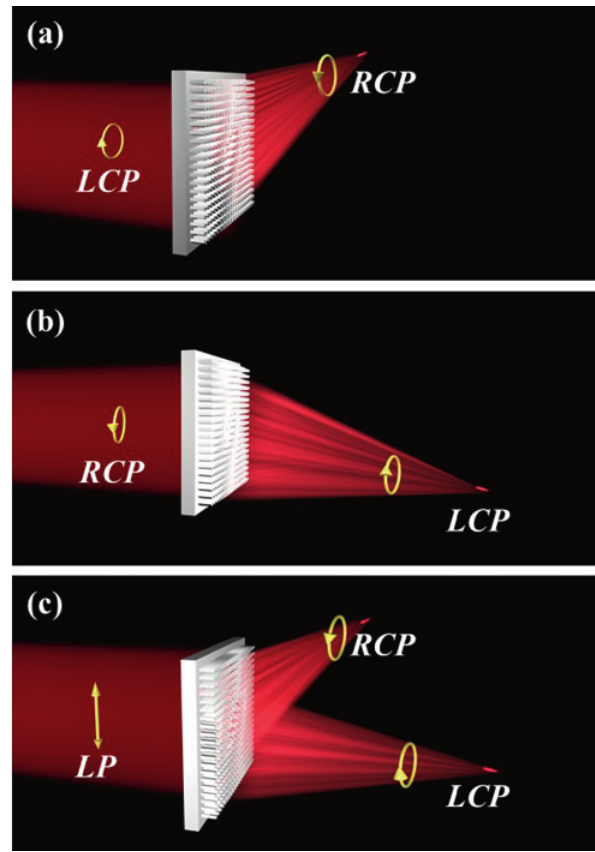
Figure 1: Schematic of the multidimensional manipulation of photonics SHE. (a)For the incidence of LCP THz waves, one RCP focal point is observed and located at an arbitrary position. (b) For the incidence of RCP THz waves, one LCP focal point is observed and located at anarbitrary position.(c) Under theillumination of linearly polarized THz waves, two separated spin-dependent (LCP and RCP) focal spots are manipulated and distributed in arbitrary positions. The arrays represent the polarization state of the THz